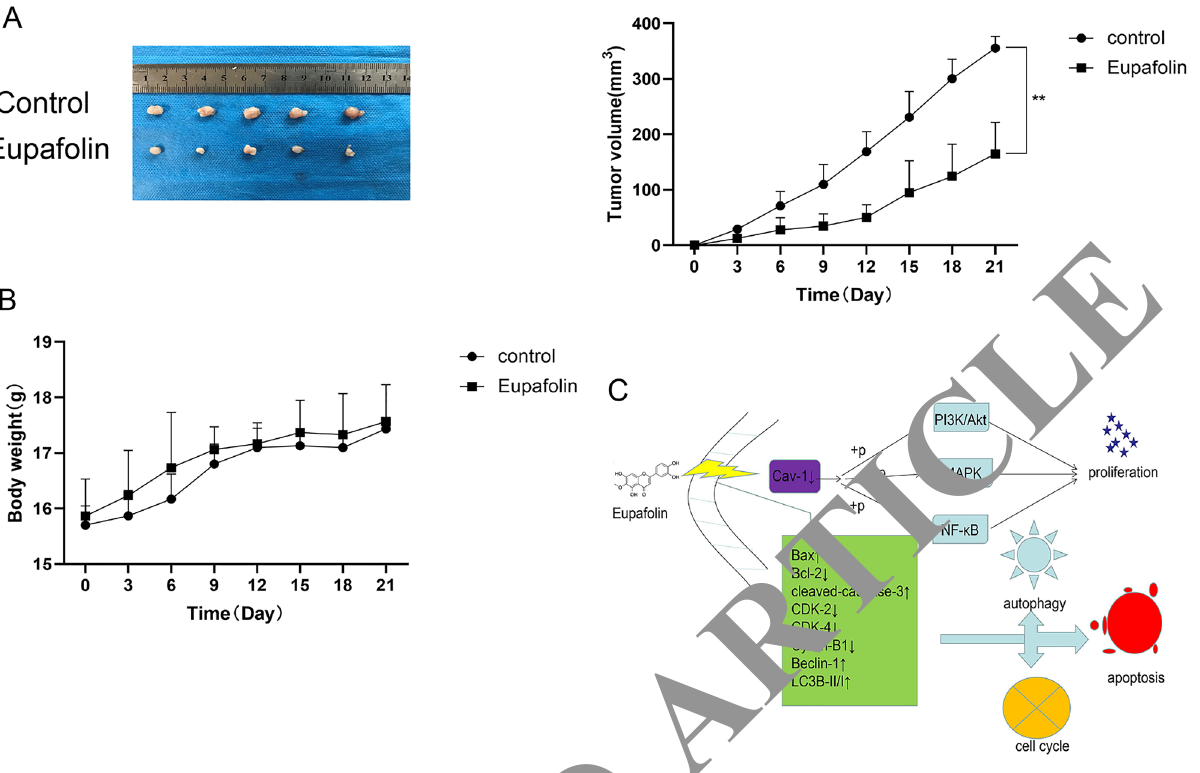
Figure 7. Eupafolin inhibited the oncogenic capability of MCF-7 cells in nude mouse xenografts. ( A ) Nude mice bearing MCF-7 tumor xenografts were treated with Eupafolin (50 mg/kg, once daily, intraperitoneal injection). ( B ) Body weight of nude mice. ( C ) Schematic diagram of the potential molecular mechanism of Eupafolin-induced anticancer effect. The interaction between Eupafolin and PI3K/AKT, MAPKs and NF-κB is demonstrated. Data are representative of three independent experiments and expressed as mean ± SD. P > 0.05 indicates non-significance; ***P < 0.001; **P < 0.01; *P <